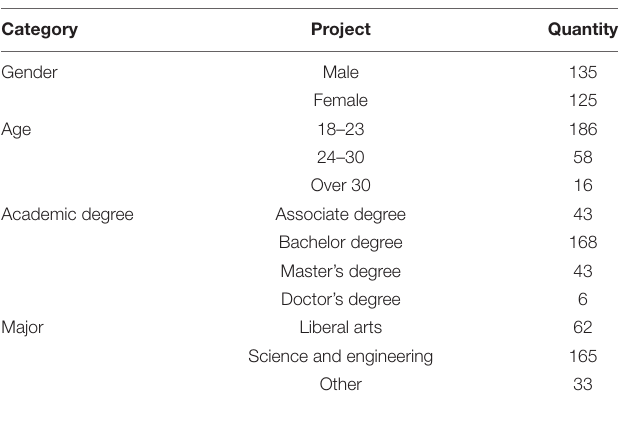
TABLE 2 | Statistics of